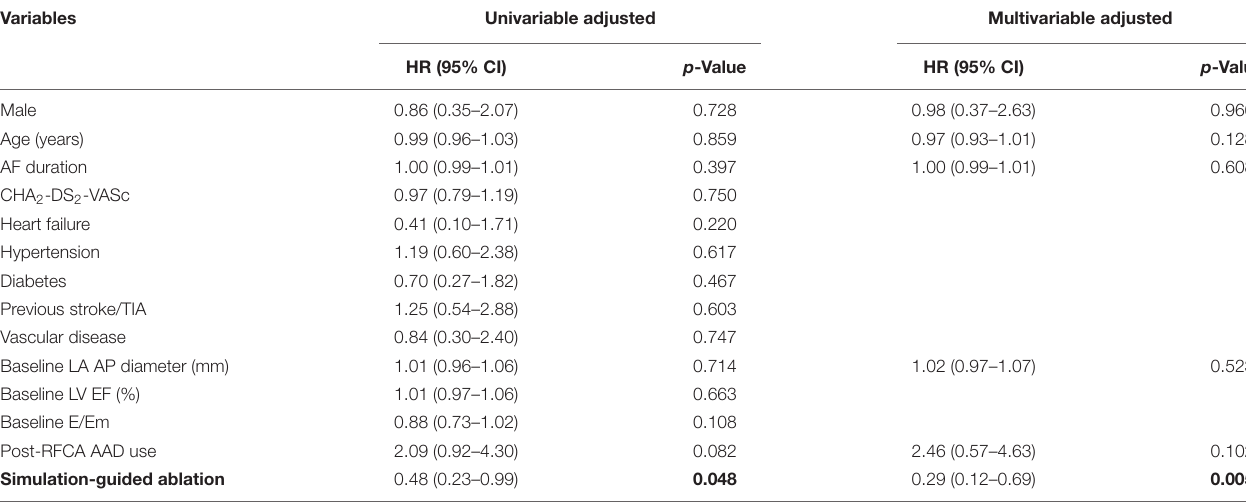
TABLE 4 | Factors associated with a post-RFCA clinical recurrence of AF (Cox proportional-hazard model regression analysis). Variables Univariable adjusted Multivariable